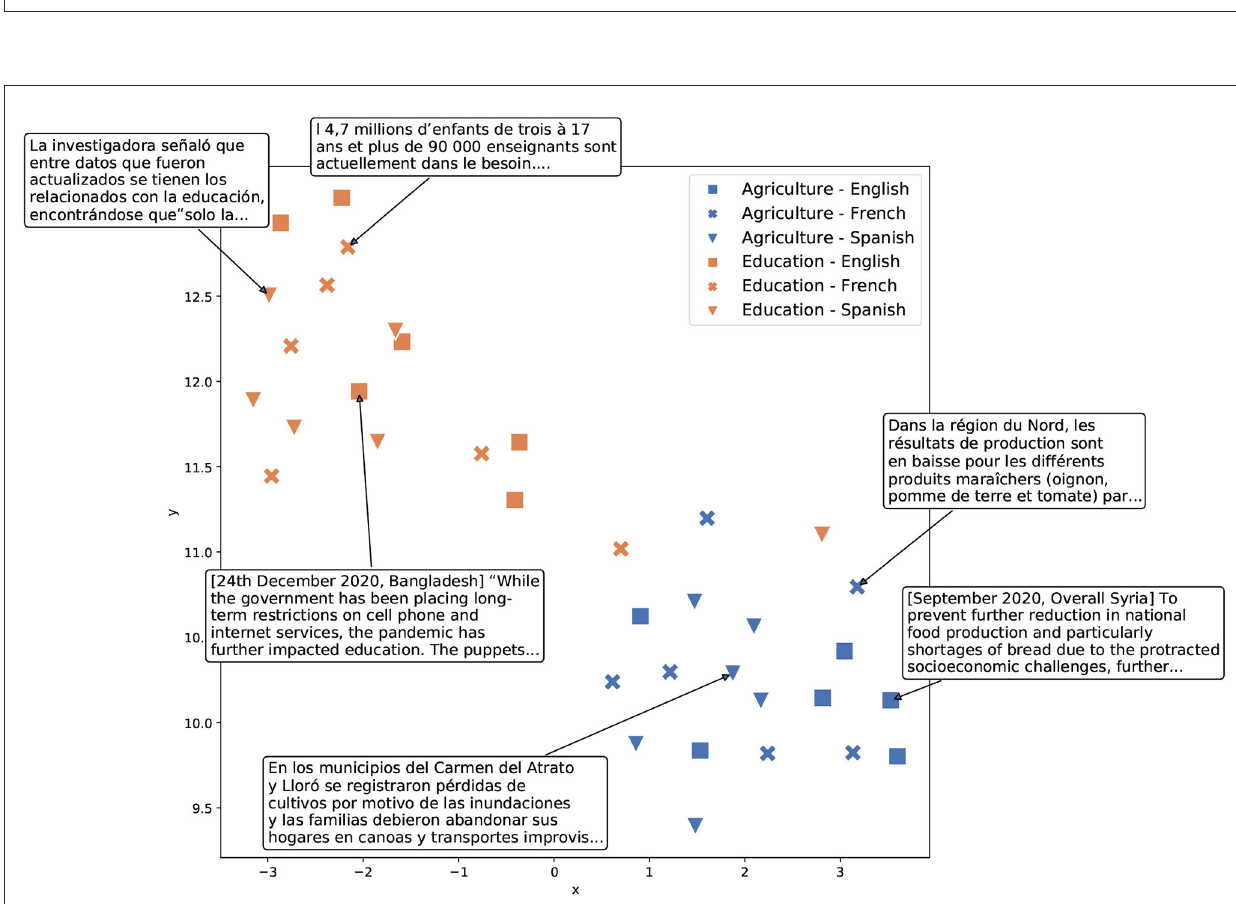
FIGURE1 Toy example of distributional semantic representations, figure and caption from Boleda and Herbelot (2016), Figure 2, (with adaptations). On the left, a toy distributional semantic lexicon, with words being represented through 2-dimensional vectors. On the right, the representations of those words in semantic space. Semantic distance between words can be computed as geometric distance between their vector representations. Words with more similar meanings will be closer in semantic space than words with more different meanings. In this specific example, distance (see arcs) between vectors for food and water is smaller than the distance between the vectors for water and car .